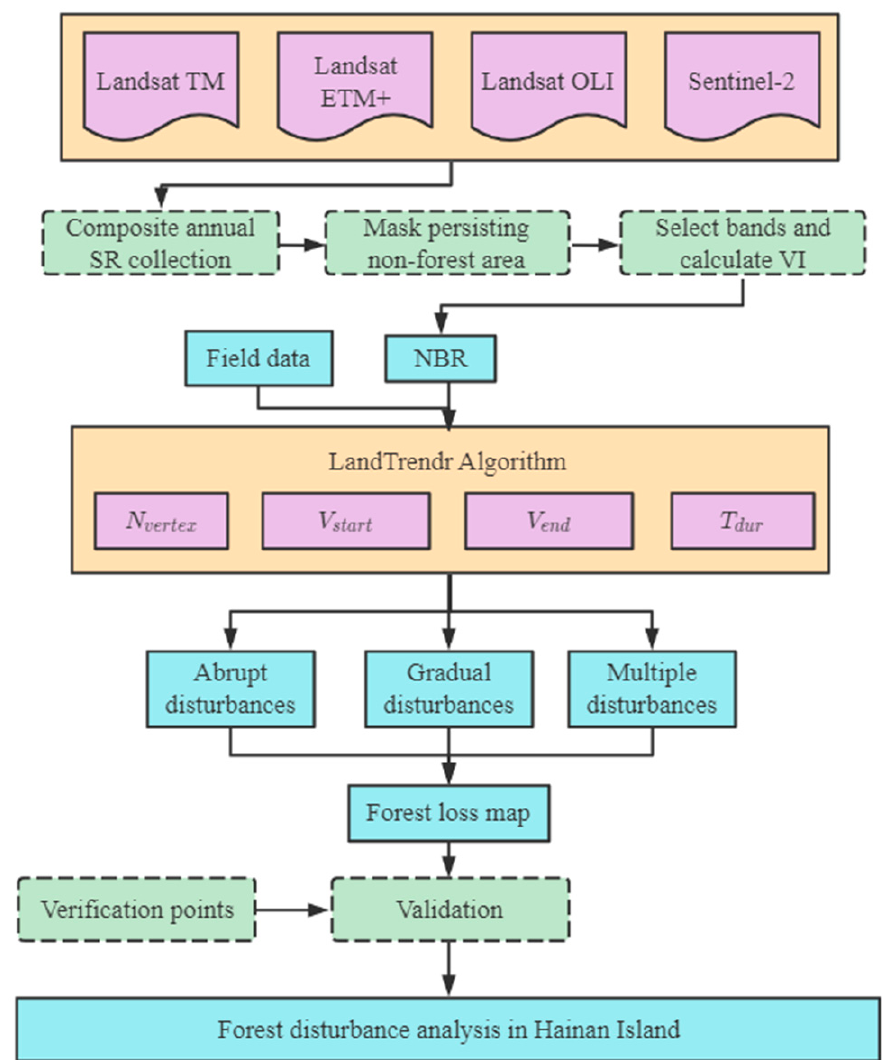
Figure 2. Workflow of this